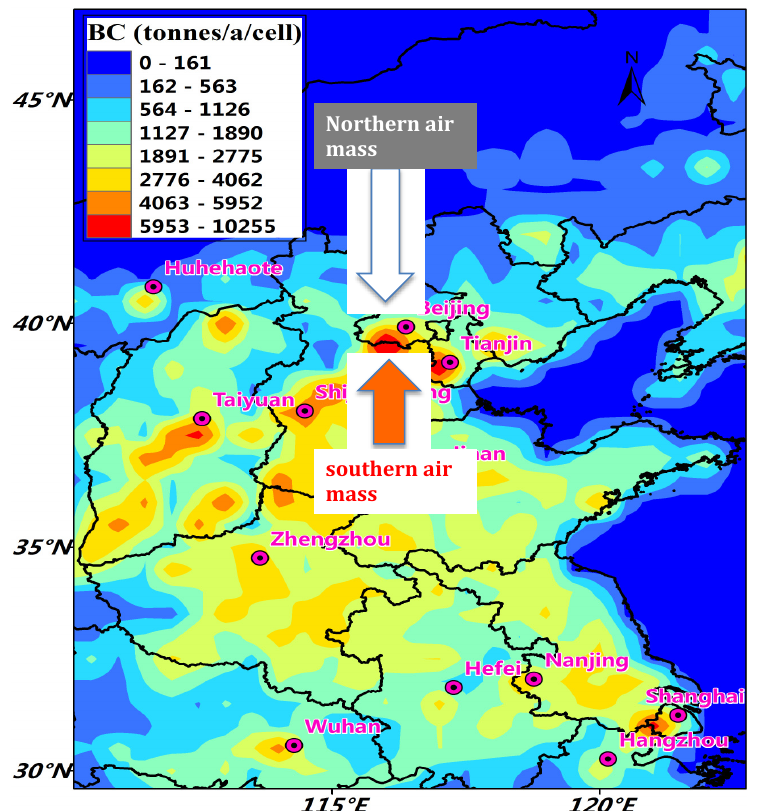
Figure 2. rBC emissions in the region (unit, ton/year in a 0.5° × 0.5° grid). The white arrow indicates the northern air mass from the remote region, and the orange arrow indicates the southern air mass from the polluted